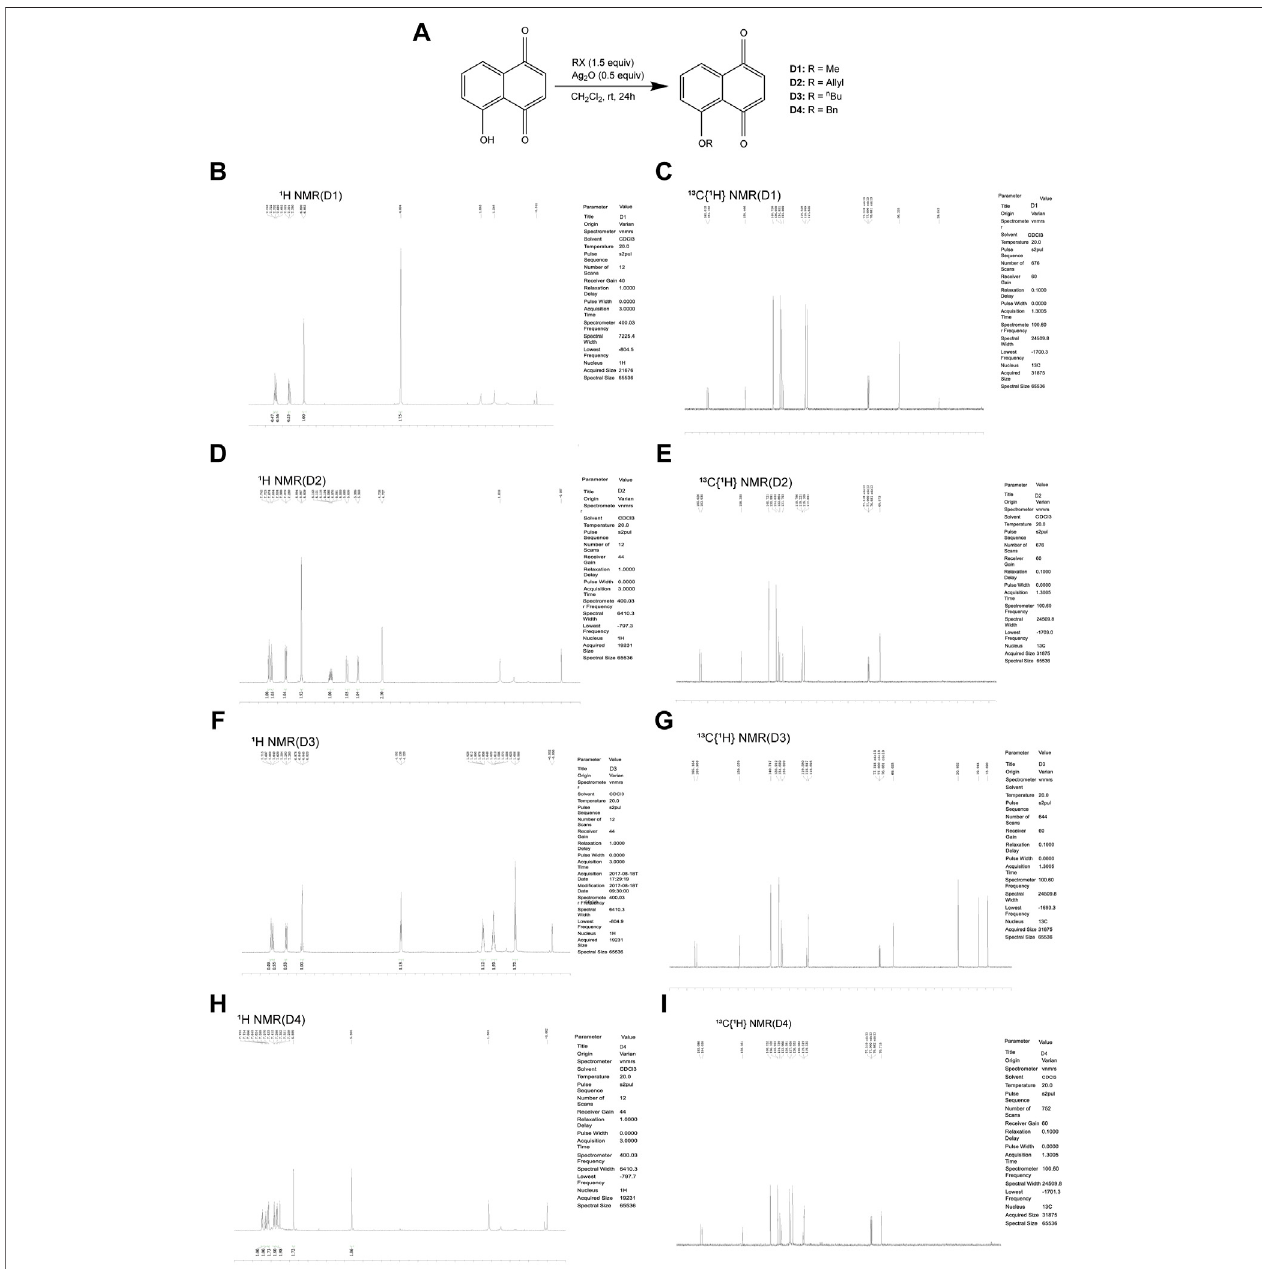
FIGURE 2 | Chemical synthesis of juglone derivatives and identi fi cation with NMR spectra. (A) Chemical synthesis process of juglone derivatives. (B)(D)(F)(H) Identi fi cation of juglone derivatives with 1H NMR spectra (D1, D2, D3, D4 respectively). (C)(E)(G)(I) Identi fi cation of juglone derivatives with 13 C{1H} NMR spectra (D1, D2, D3, D4 respectively)